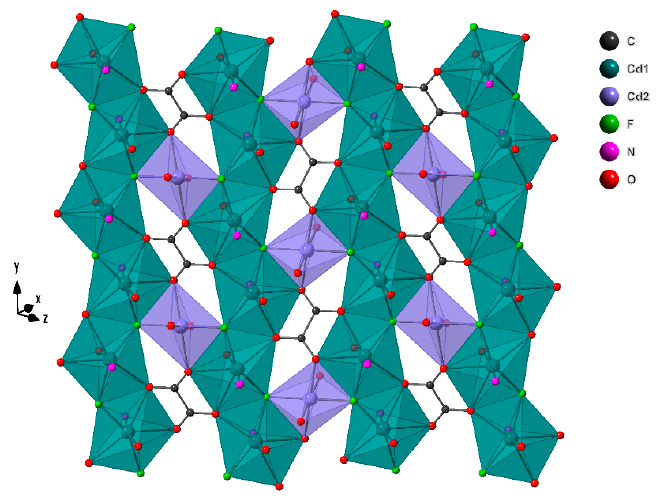
Figure 2. [Cd 3 (ox)F 2 ] n2n+ layer present in the crystal structure of compound 1 .